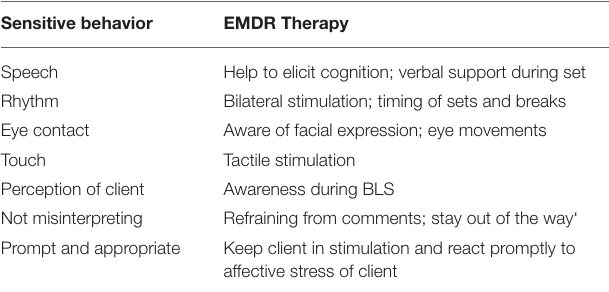
TABLE 1 | Sensitivity and EMDR